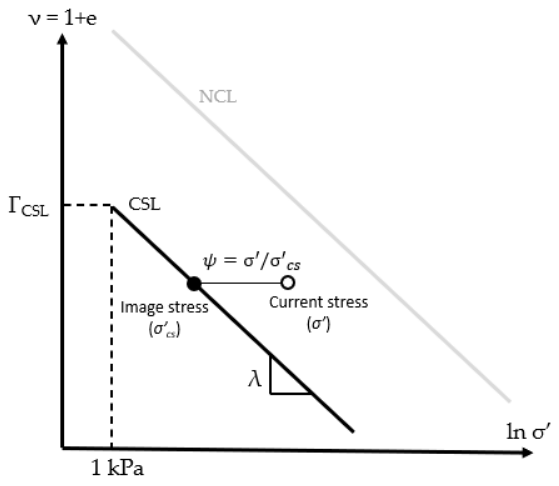
Figure 7. Model for undrained shearing of the representative soil